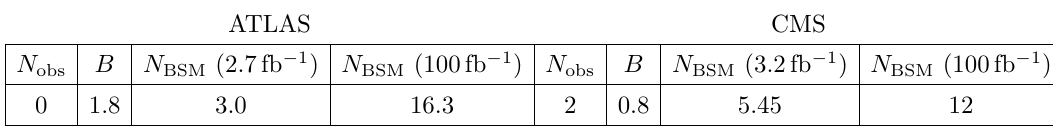
Table 1 . Upper limits on cross section times luminosity in the analysis window, N BSM , from the recast of ATLAS and CMS